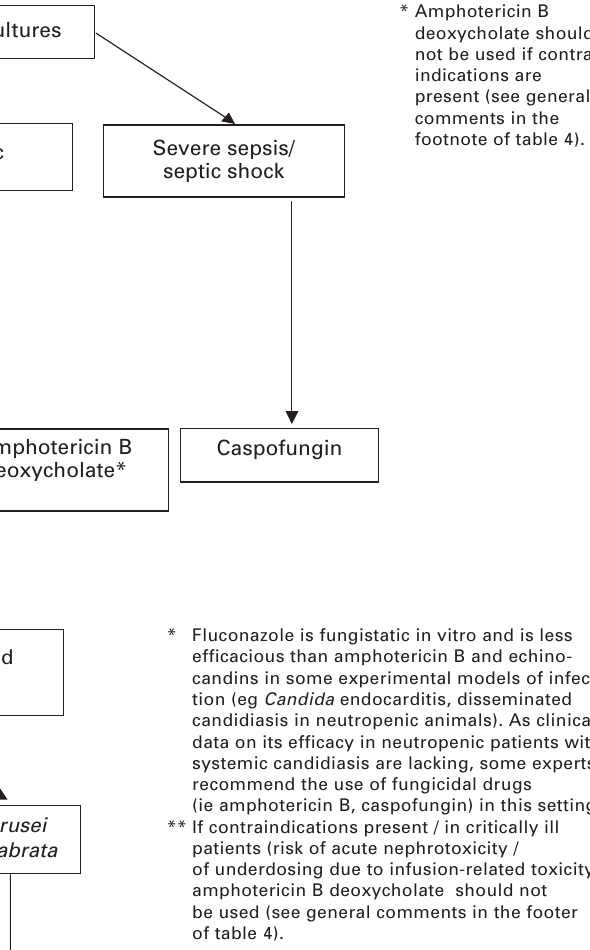
Detection of Candida in blood cultures: empirical antifungal therapy before identification of Candida species. For dosages and alternative drugs